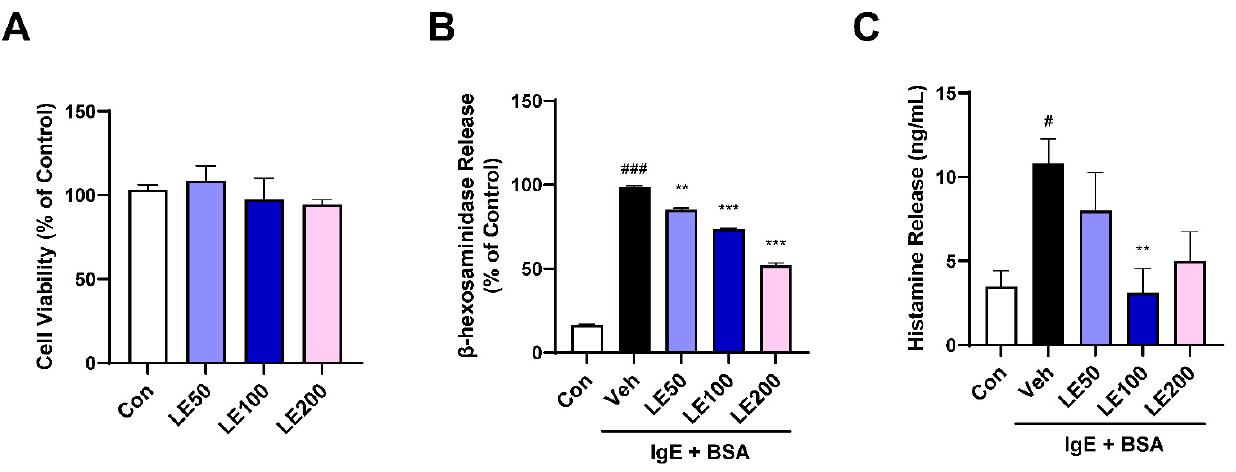
Figure 4. LE suppresses degranulation and production of allergy-related cytokines in RBL-2H3 cells. ( A ) The viability of cells was assessed 24 h after treatment with 50, 100, and 200 μ g/mL LE. ( B , C ) Fc ε RI-mediated degranulation assay. The cells were sensitized with anti-DNP-IgE and then treated with LE (50, 100, or 200 μ g/mL) for 1 h prior to challenge with DNP-BSA. ( B ) β -hexosaminidase release was measured after stimulation with DNP-BSA. ( C ) Histamine was measured in an ELISA. Data are expressed as the mean ± SEM. # p < 0.05, ### p < 0.001, versus the control group. ** p < 0.01, *** p < 0.001 versus the vehicle group.